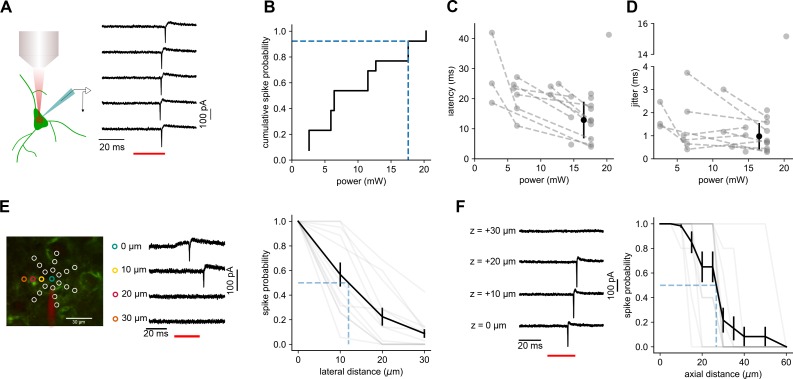
Characterization of two-photon photostimulation.(A) Cartoon illustrating loose-seal recording configuration utilized to test photostimulation parameters. Example recording of repeated photostimulation or a ReaChR-positive cell. (B) Cumulative probability plot of minimum power necessary to reliably evoke action potentials for 13 cells. Blue dashed lines indicate light power utilized in mapping experiments and the fraction of cells reliably activated. (C) Average latency of light-evoked action potentials plotted against photostimulation intensity for individual neurons (grey dashed lines). Filled black circle and error bars represent the mean and standard deviation of latency measured across all cells at a power used for mapping. (D) Average jitter of light-evoked action potentials plotted against photostimulation intensity. Data from individual cells and population average plotted as in panel C. (E) Left: Example experiment illustrating the radial grid pattern used to measure the lateral resolution of photostimulation and example traces recorded during the photostimulation at indicated locations. Right: Probability of generating light-evoked action potentials plotted against lateral distance from the center of the cell. (F) Left: example of responses resulting from photostimulation at indicated axial offsets. Right: Probability of generating light-evoked action potentials plotted against axial distance from the center of the cell.10.7554/eLife.37349.019Figure 4—figure supplement 2—source data 1.Characterization of two-photon photostimulation.